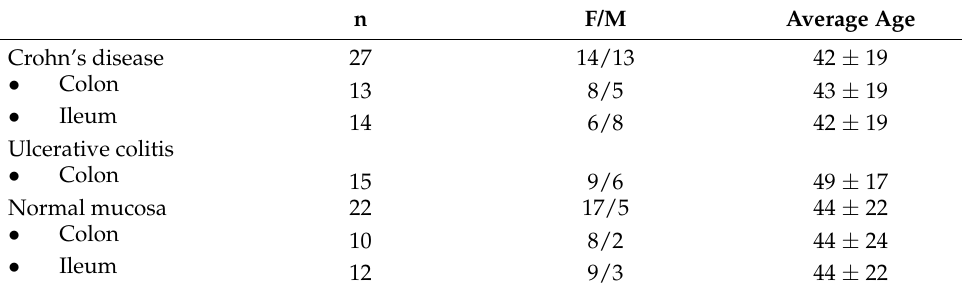
Table 2. Clinical characteristics of patients. n, number of samples; F, female; M, male. n F/M Average Age Crohn’s disease 27